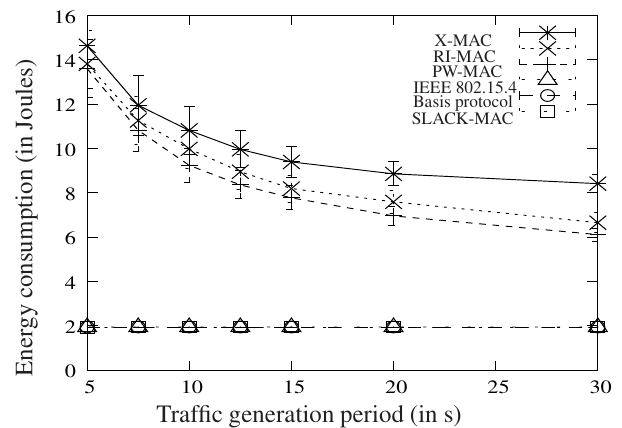
Figure 9. Energy consumption as a function of the traffic generation period, for a duty-cycle of 1 %, and for several